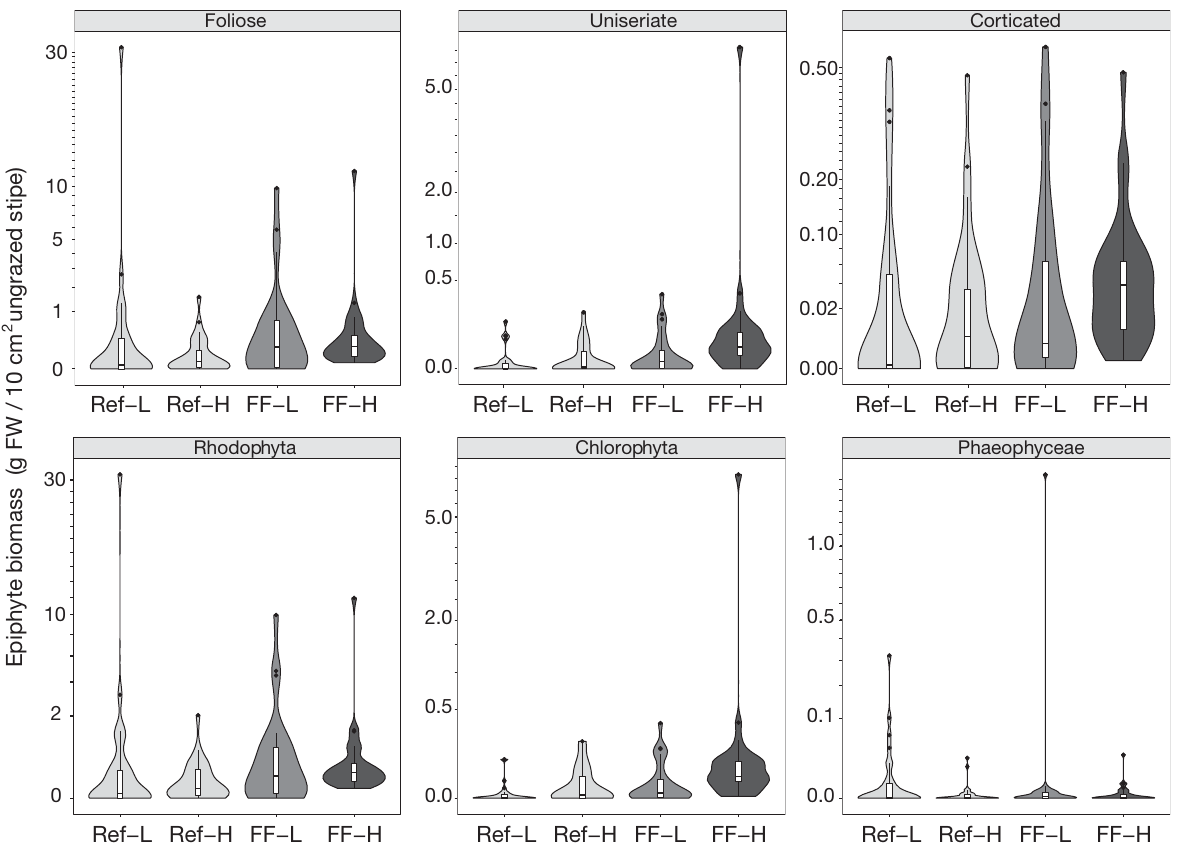
Fig. 6. Biomass of macroalgal epiphytes on stipes of Laminaria hyperborea kelp canopy plants collected at fish farm sites (low effluent levels: FF-L; high effluent levels: FF-H) and reference sites (Ref-L, Ref-H) in the Frøya (Ref-L, FF-L) and Smøla (Ref-H, FF-H) archipelagos, Norway. Epiphytes are split by morphological type and by taxonomic group. Note that the y -axes are on different square root scales. For plot explanation, see Fig.